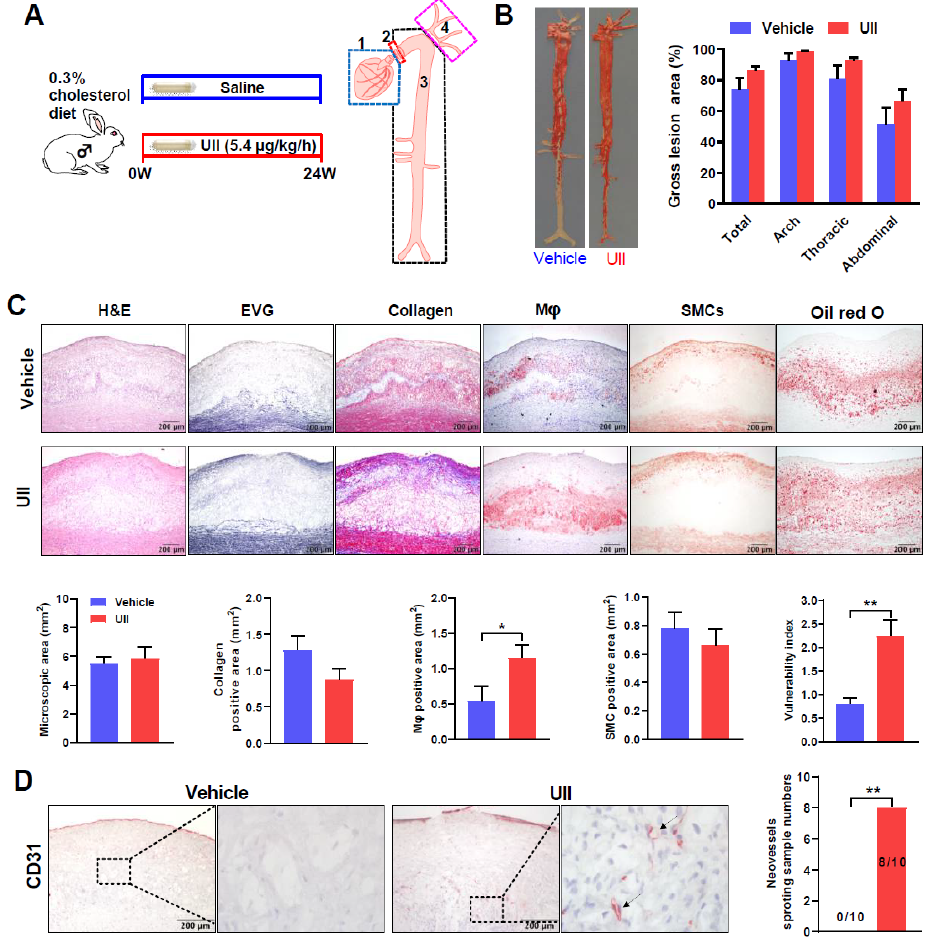
Figure 2. Schematic illustration of the advanced plaque experiment design and gross lesion analysis. ( A ) Rabbits were fed an HCD and were infused with either UII (5.4 µ g/kg/h) or saline via osmotic mini-pumps for 24 weeks (left panel). Aortic trees along with the heart were collected and divided into 4 parts for the following analysis: coronary plaque analysis (1); an aortic ring for calculating plaque vulnerability index (2); remaining aorta tree for analyzing aortic lesions (3), and carotid and subclavian arteries of the aortic branches (4) (right). ( B ) The representative images of Sudan IV-stained aortas from each group (left panel). Quantification of the sudanophilic area of the whole aortas was shown (right panel). ( C ) Microscopic analysis of the aortic lesions. Representative micrographs stained by H&E, EVG, collagen, macrophages (M ϕ ), SMCs, and Oil red O from each group (upper panel). Quantifications of microscopic atherosclerotic area, collagens, M ϕ , and SMCs and vulnerability index of aortic arch plaques (lower panel). * p < 0.05, ** p < 0.01 vs. vehicle group. ( D ) Analysis of intra-plaque angiogenesis. Neovessels in the aortic plaques were detected by CD31 staining (arrows). The number of animals with intra-plaque neovessels was calculated. Fisher’s exact test was performed to compare the intra-plaque angiogenesis between the two groups. All data are presented as mean ± SEM, n =